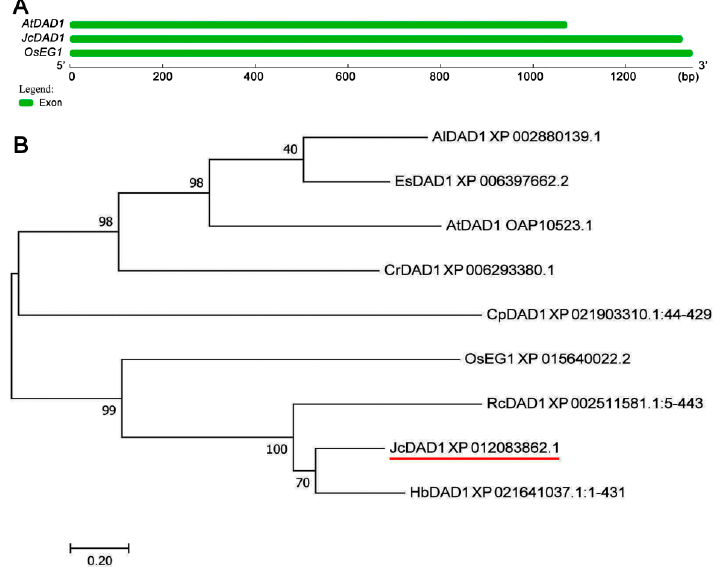
Figure 1. Structural and phylogenetic analysis of DAD1 genes among Jatropha and other species. ( A ) Genomic organization of DAD1 . ( B ) Phylogenetic analysis of deduced DAD1 proteins. EG1 , a rice ortholog of Arabidopsis DAD1 . Al, Arabidopsis lyrata ; At, Arabidopsis thaliana ; Cp, Carica papaya ; Cr, Capsella rubella ; Es, Eutrema salsugineum ; Hb, Hevea brasiliensis ; Jc, Jatropha curcas ; Os, Oryza sativa ; Rc, Ricinus communis . The GenBank accession numbers in the phylogenetic tree are listed in Supplementary Table S1.